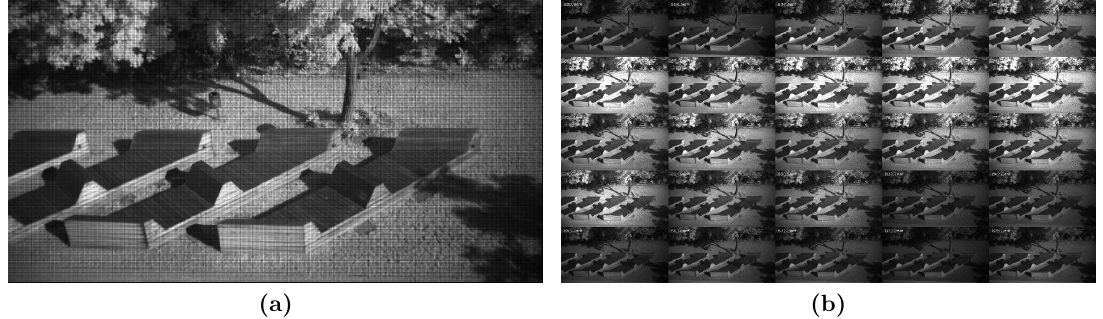
Figure 3. ( a ) Hyperspectral input frame and ( b ) planar hyperspectral cube after